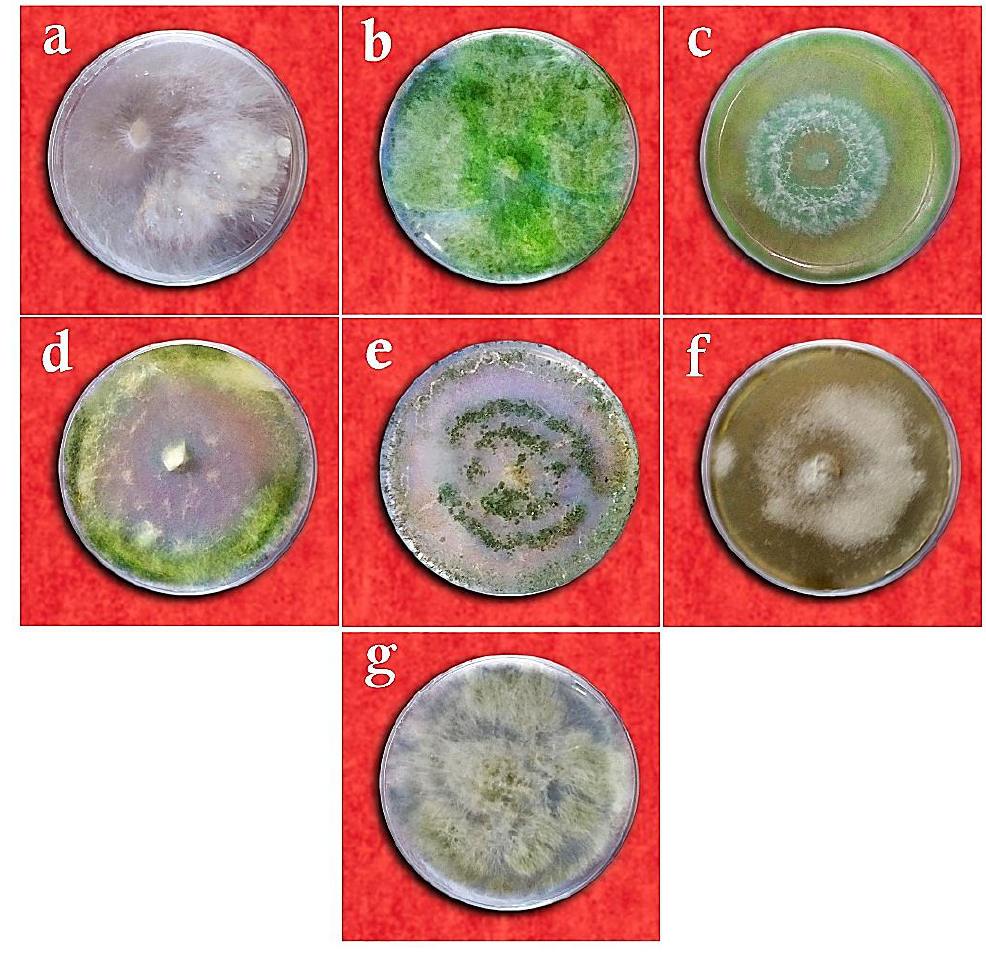
Figure 5. Volatile metabolites test of Sclerotium rolfsii versus the studied fungi on the PDA medium: ( a ) Sclerotium rolfsii (control), ( b ) Penicillium rubens (MN395854.1), ( c ) Aspergillus flavus , ( d ) Penicillium rubens (MN395851.1), ( e ) Trichoderma viride , ( f ) Trichoderma virens , ( g ) Penicillium decaturense .